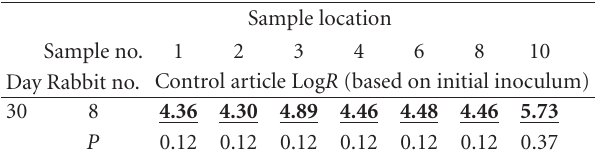
Table 5: Catheter (CFU/catheter segment) Log reduction summary tables for day 30. Log reduction values higher than 4 are bold and underlined.